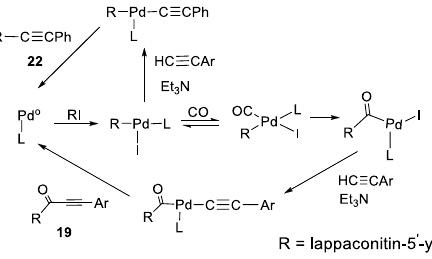
Table 1. Analgesic activity of compounds 1 , 9 , 10 , 12 , 13 , 15 , 16 , 20 , 21 and Diclofenac sodium.